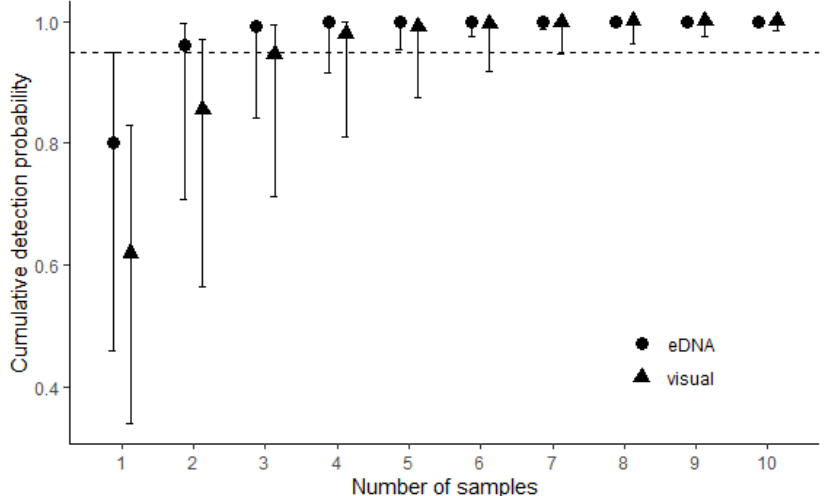
Figure 2. Cumulative detection probabilities with 95% confidence intervals of longnose darter Percina nasuta in the St. Francis River drainage of Missouri. Black circles (eDNA surveys) and black triangles (visual surveys) represent detection probabilities based on output from multi-scale single-season occupancy models in the mainstem St. Francis River. The dashed line denotes the 95% detection probability threshold.